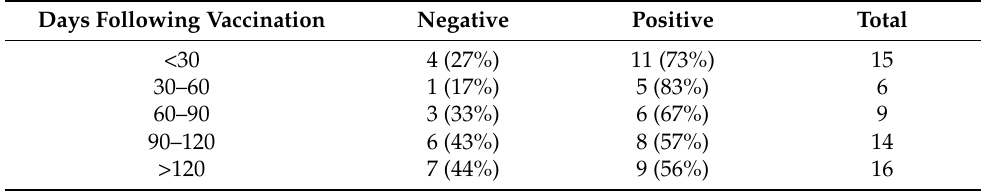
Table 2. Summary of patient visits following vaccination.